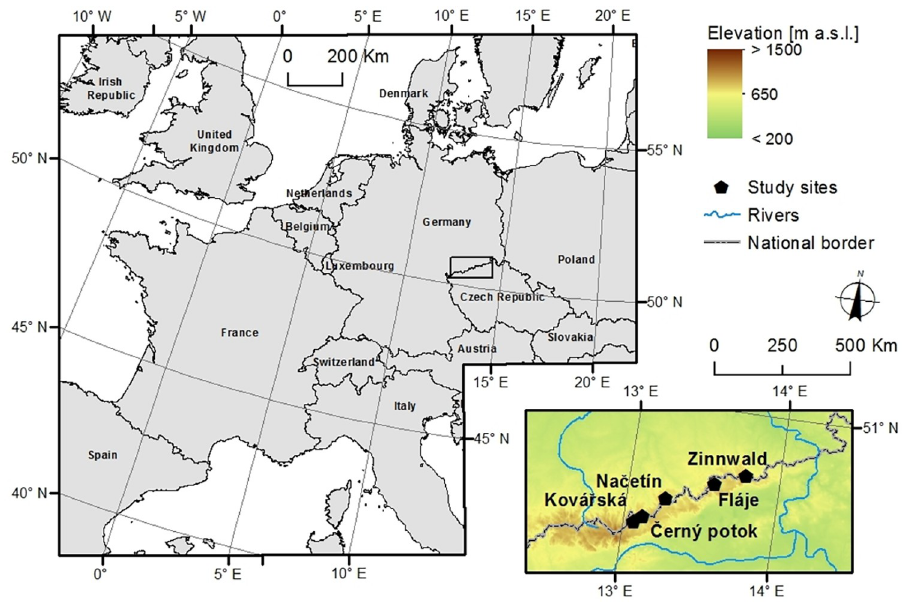
Fig 1. Study site locations in Ore Mts., Czech Republic. The maps are based on data from OpenStreetMap and OpenStreetMap Foundation publicly available without special privileges under a CC BY-SA 2.0 licence from the OpenStreetMap contributors (https://www.openstreetmap.org/copyright/en) available from www.openstreetmap.org.